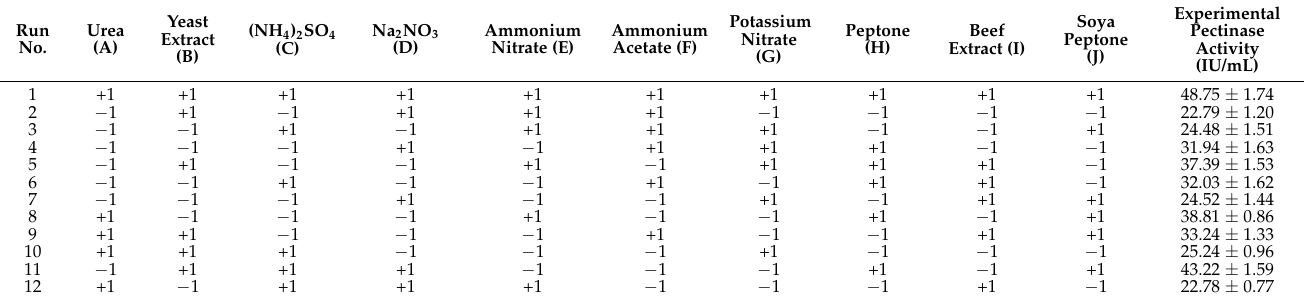
Table 7. The PB design matrix for nitrogen sources with the